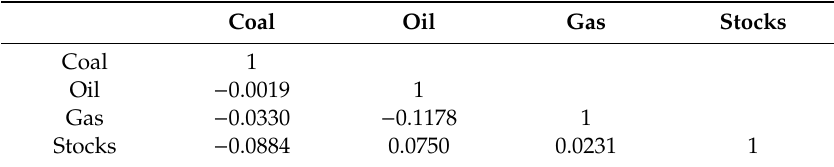
Table 21. Correlations for Singapore.